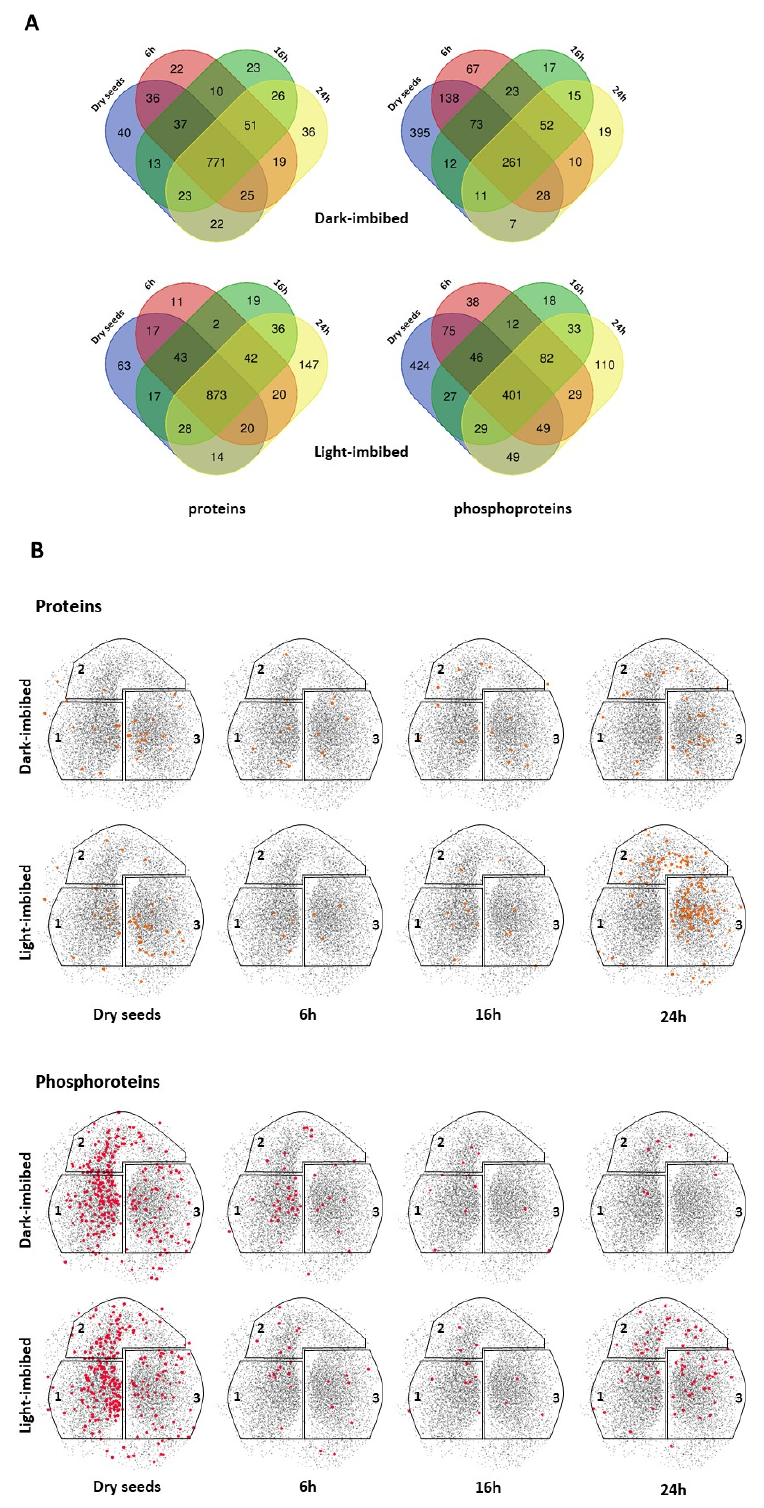
Figure 6. Modifications of DI and LI seed proteomes and phosphoproteomes during imbibition. ( A ) overlap of the proteins and phosphoproteins detected in dry and LI or DI seeds. ( B ) localization of proteins (orange dots) and phosphoproteins (red dots) specifically detected in each condition in the SeedNet network. SeedNet region 1 and 3 gather co-regulated genes/proteins associated with dormancy and germination, respectively. Genes/proteins with unspecific patterns gather in the network’s region